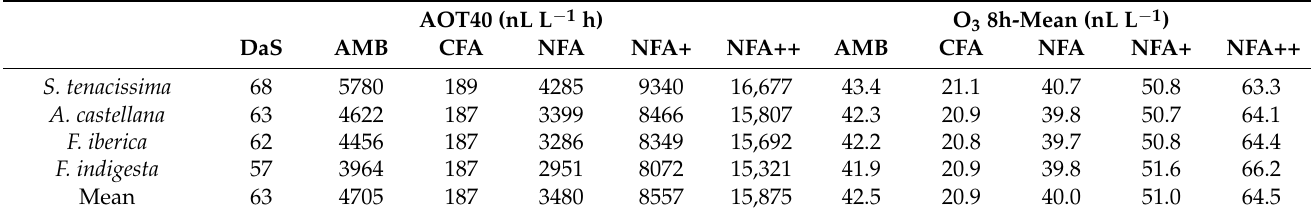
Table 1. Ozone exposure during the whole experimental period for the different grasses: accumulated O 3 exposure index AOT40 and O 3 8h-mean. DaS, days after the start of the O 3 exposure.